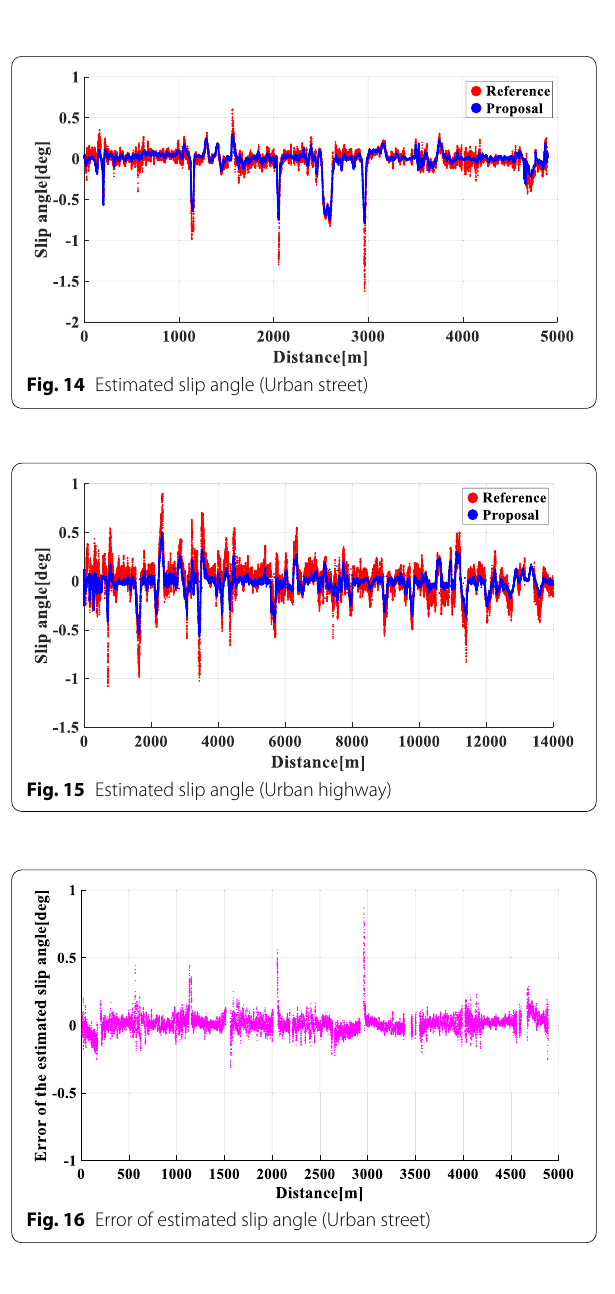
both the courses. Furthermore, the difference between the reference and estimated slip angles are presented in Figs. 16 and 17; the error in the estimated slip angle is shown in Table 4. Table 4 shows that both courses were estimated with high accuracy, with a mean error of 0.01°. In these figures, it was also confirmed that there are some points where the error becomes slightly larger when focusing on the points (curves) where large slip angles occur. This is considered to be a point where the two-wheel model used in this method is not applicable.